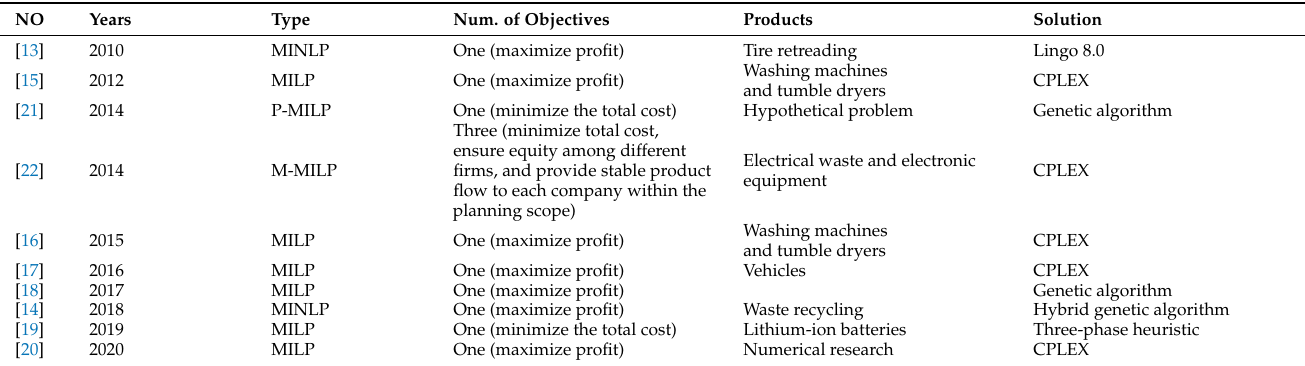
Table 2. Mathematical model of general network structure.